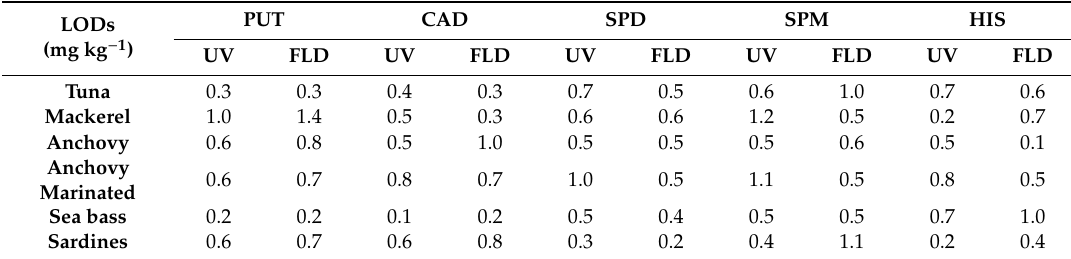
Table 5. Limit of detection (LOD) for the di ff erent matrices.